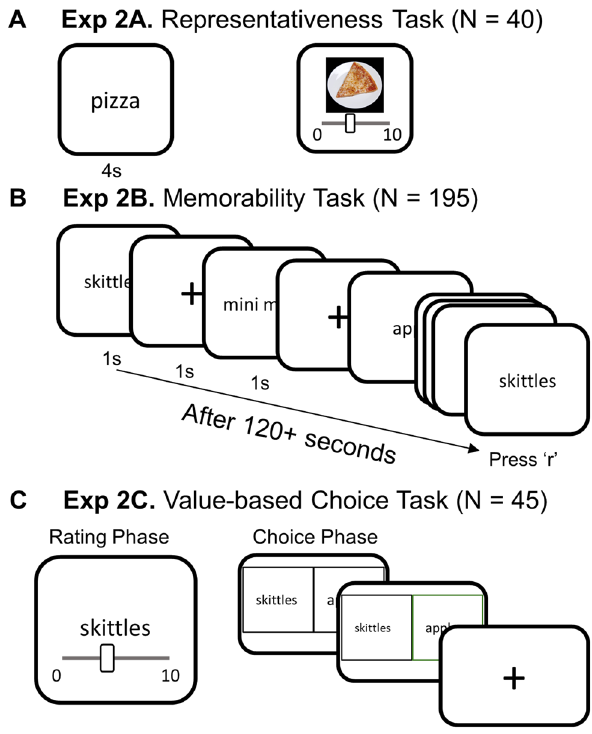
Figure 4. Diagram of tasks in Experiment 2. ( A ) Representativeness task in Experiment 2A. Participants (N = 40) were asked to picture the food depicted by the word in their mind first, then view and rate how representative the presented image was of the food they imagined. ( B ) The memorability task in Experiment 2B was identical to that in Experiment 1A, except the foods were depicted by words, rather than images (N = 195). ( C ) The value-based choice task in Experiment 2C was identical to that in Experiment 1B, except the food choice options were depicted by words, rather than images of food (N = 45). The photograph used in this figure is publicly available for download at https:// osf. io/ 483mx 22